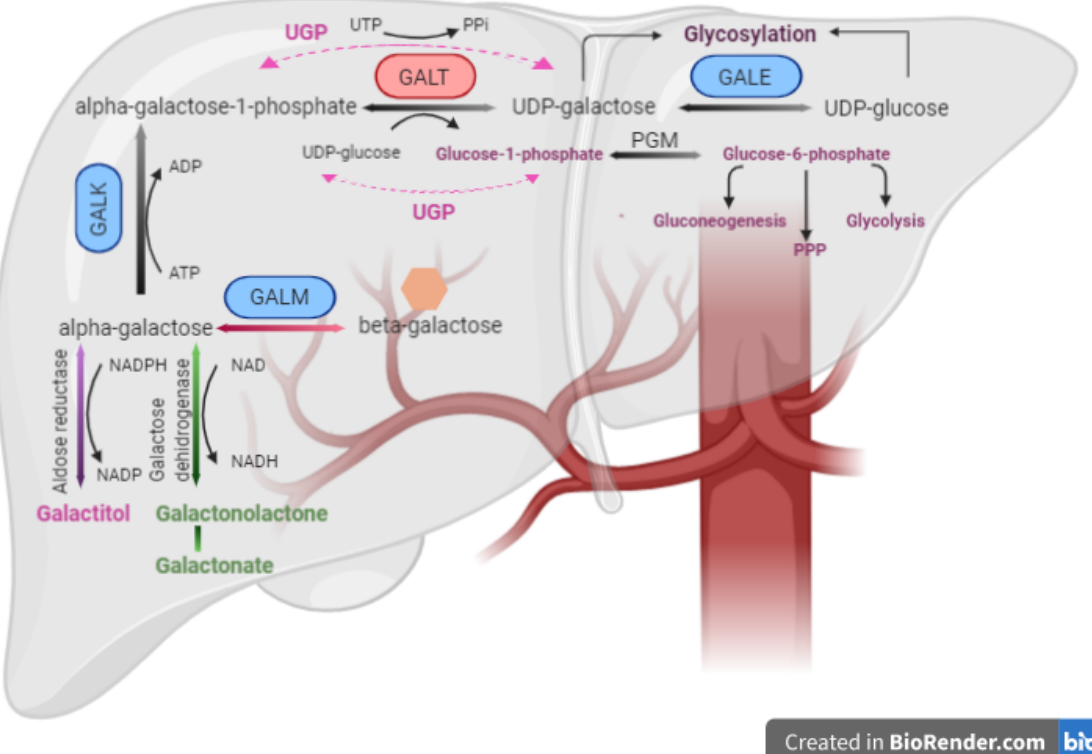
Figure 1. Galactose metabolism (Leloir pathway and other routes). Galactose main metabolic pathway or Leloir pathway (blue color), involves the following enzymes: galactose mutarotase (GALM), galactokinase (GALK), galactose-1-phosphate uridyltransferase (GALT), galactose-4-epimerase (GALE). GALT reaction product, glucose-1-phosphate, requires the action of phosphoglucomutase (PGM) to take other metabolic pathways. In the case of GALT deficiency (red), alternative pathways are activated involving different enzymes: aldose reductase (purple), galactose dehydrogenase (green) and UDP glucose/hexose pyrophosphorylase (UGP)